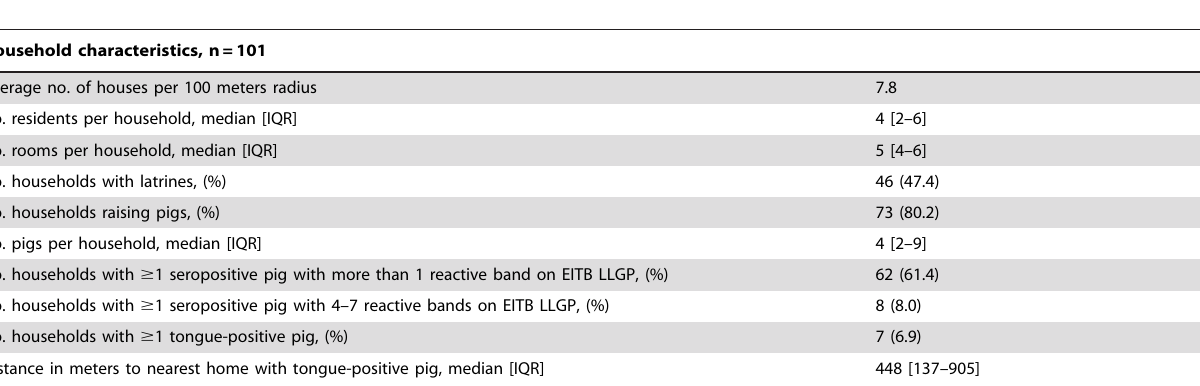
Table 1. Characteristics of households, Rica Playa, Tumbes, Peru.